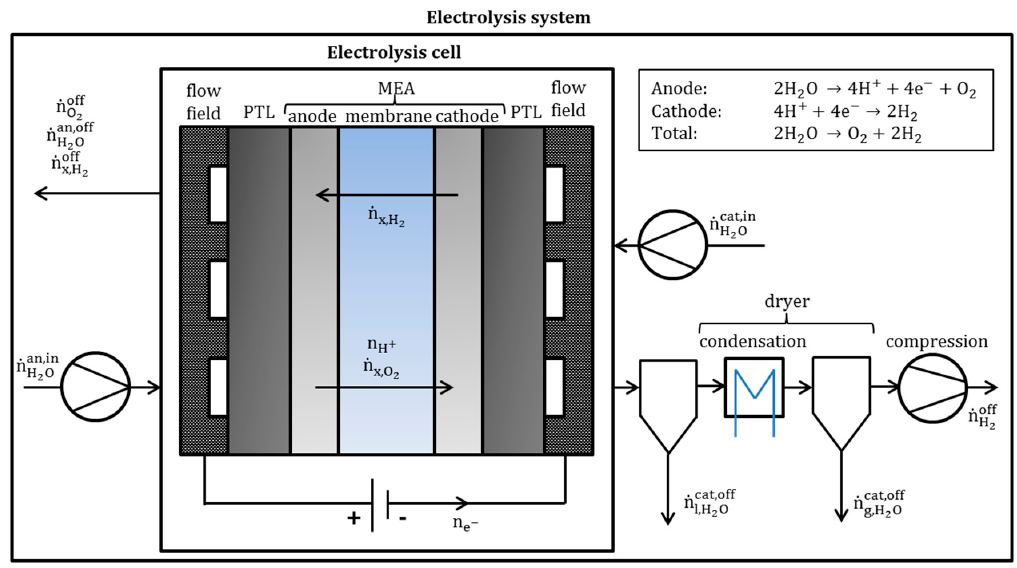
Figure 1. Schematic structure of an electrolysis cell and system including the fluid flows. The indices symbolize flows into (in) the cell, off the cell (off), permeation across the membrane (x), cathode (cat), anode (an), gas (g), and liquid (l).